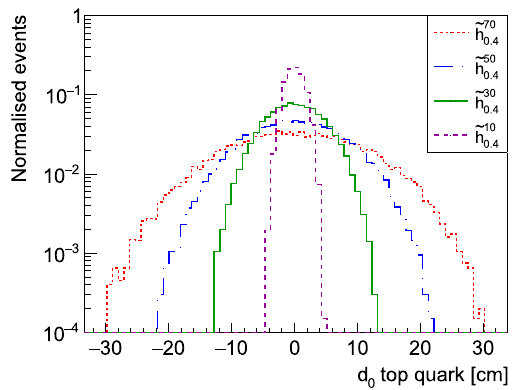
Fig. 31 Transverseimpactparameter d 0 ofthetopquarksinthe ˜ h 2 -like case with m ˜ χ 0